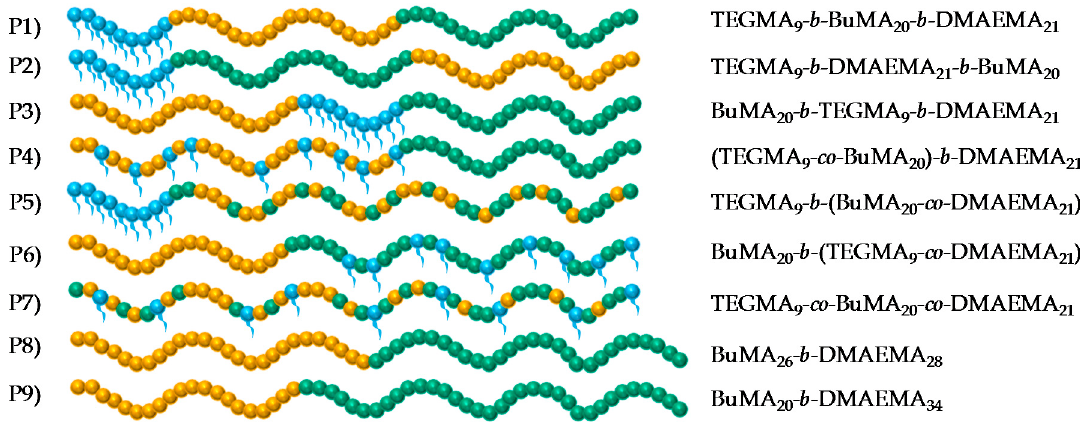
Table 1. Theoretical and experimental molar masses (MMs) and compositions, and molar mass distributions (MMDs) of the copolymers and their precursors.